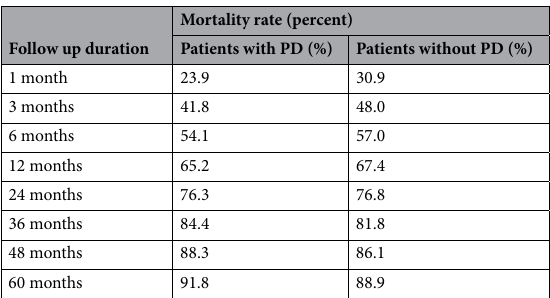
Table 4. Mortality after occurrence of aspiration pneumonia among PD patients and control group. PD Parkinson’s disease.